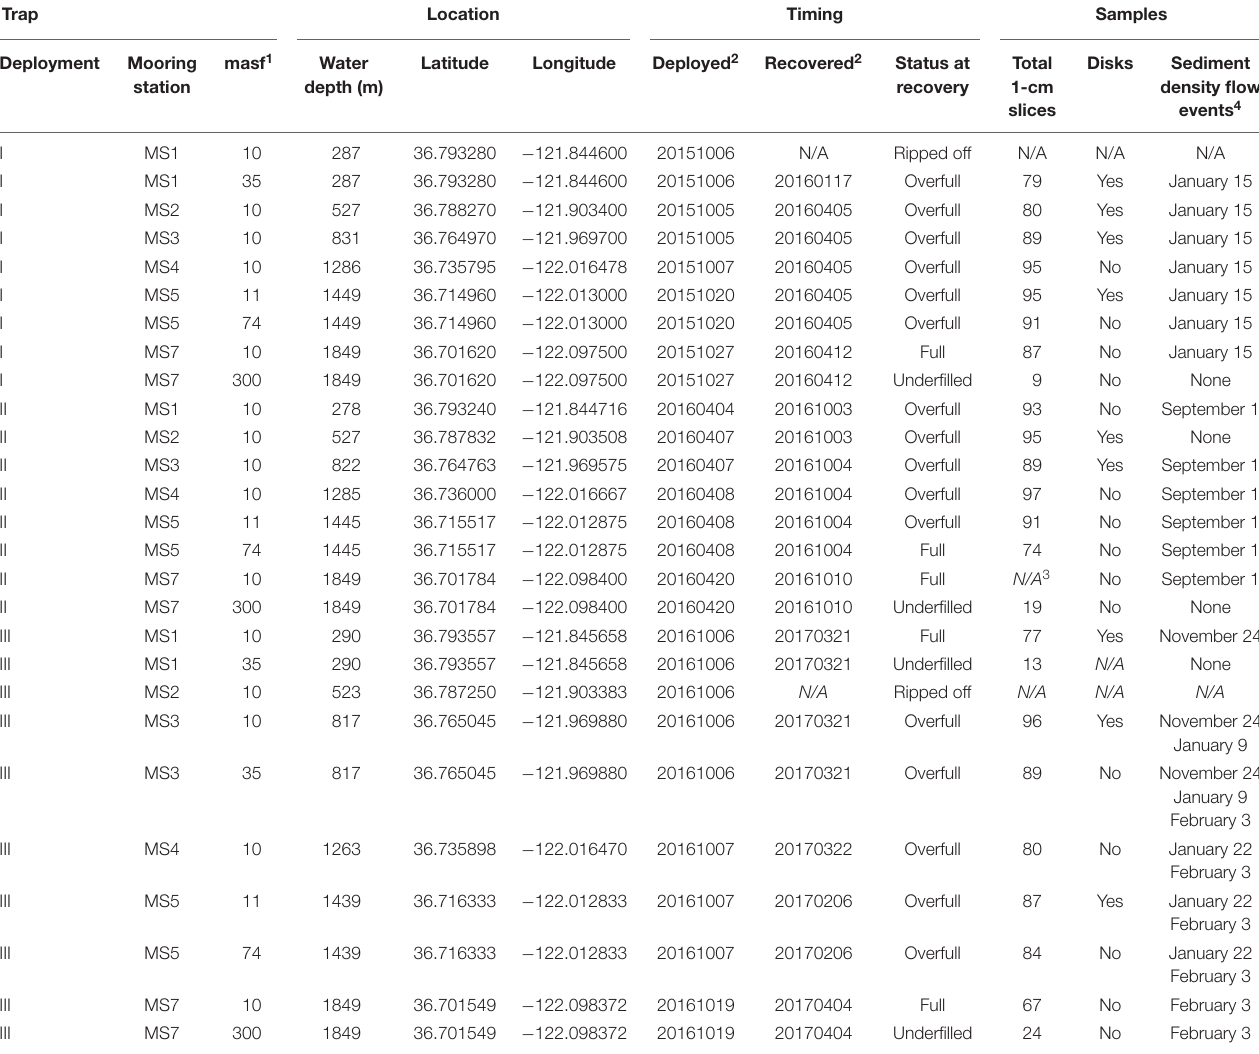
TABLE 1 | Anderson-type sediment trap samples. Trap Location Timing